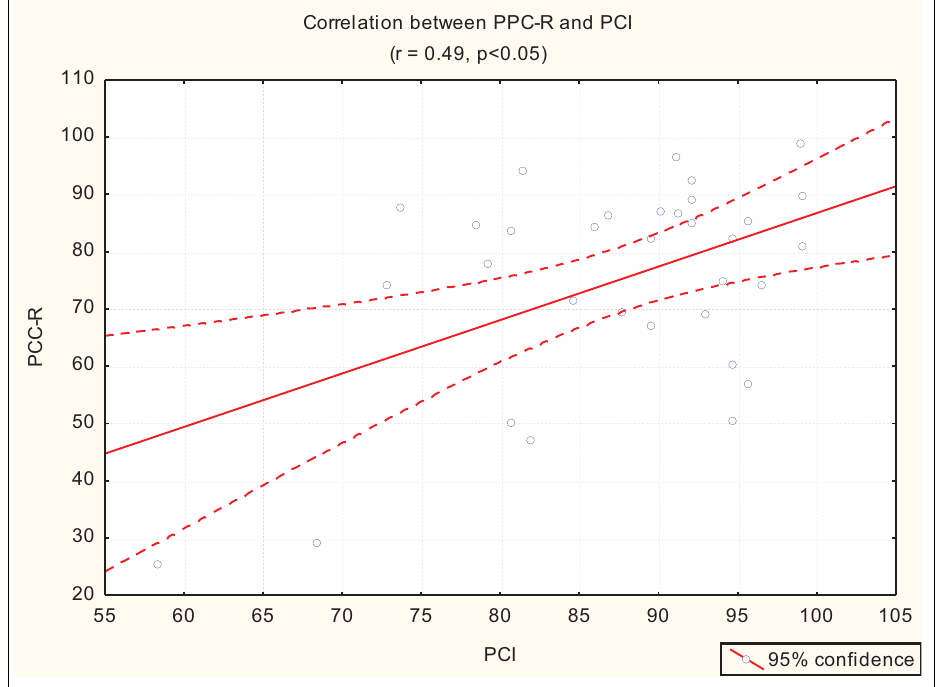
Figure 1: Correlation between speech perception and speech production performances.